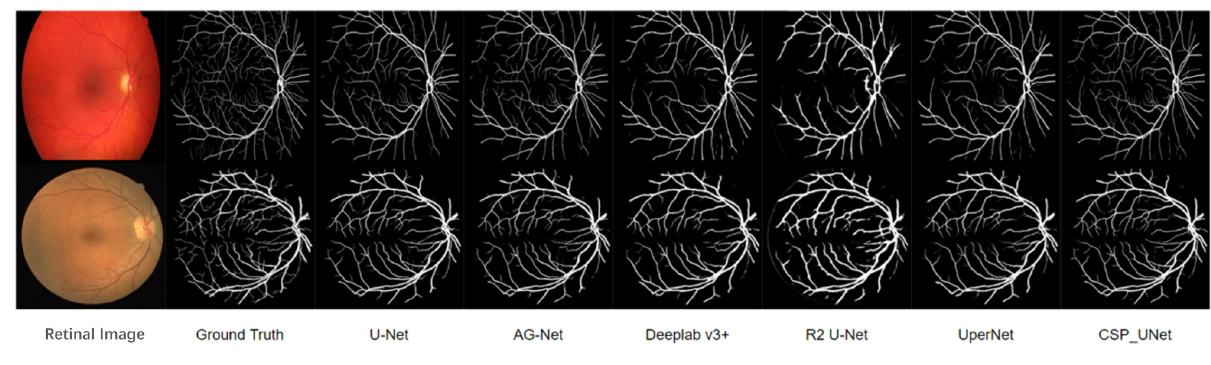
Fig 7. The segmentation effect of each model on the test set.